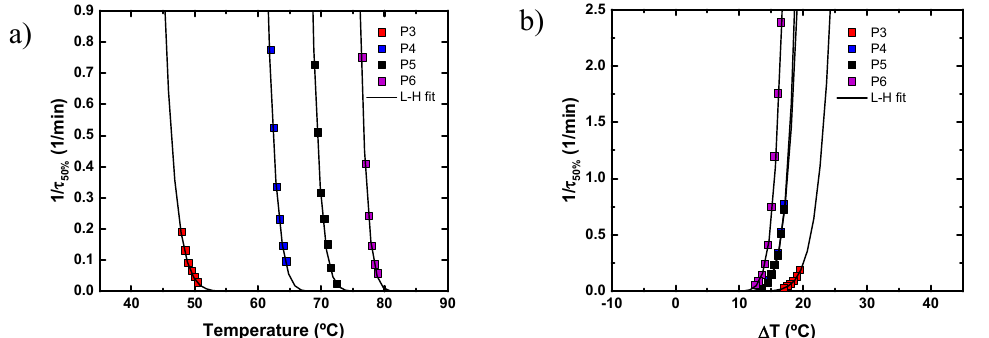
Figure 6. ( a ) Overall crystallization rate (expressed as the inverse of the half-crystallization time) versus isothermal crystallization temperature. ( b ) Overall crystallization rate (expressed as the inverse of the half-crystallization time) versus supercooling ( ∆ T = T m 0 − T c ). Symbols: experimental data. Solid lines show fits to the Lauritzen and Hoffman theory.